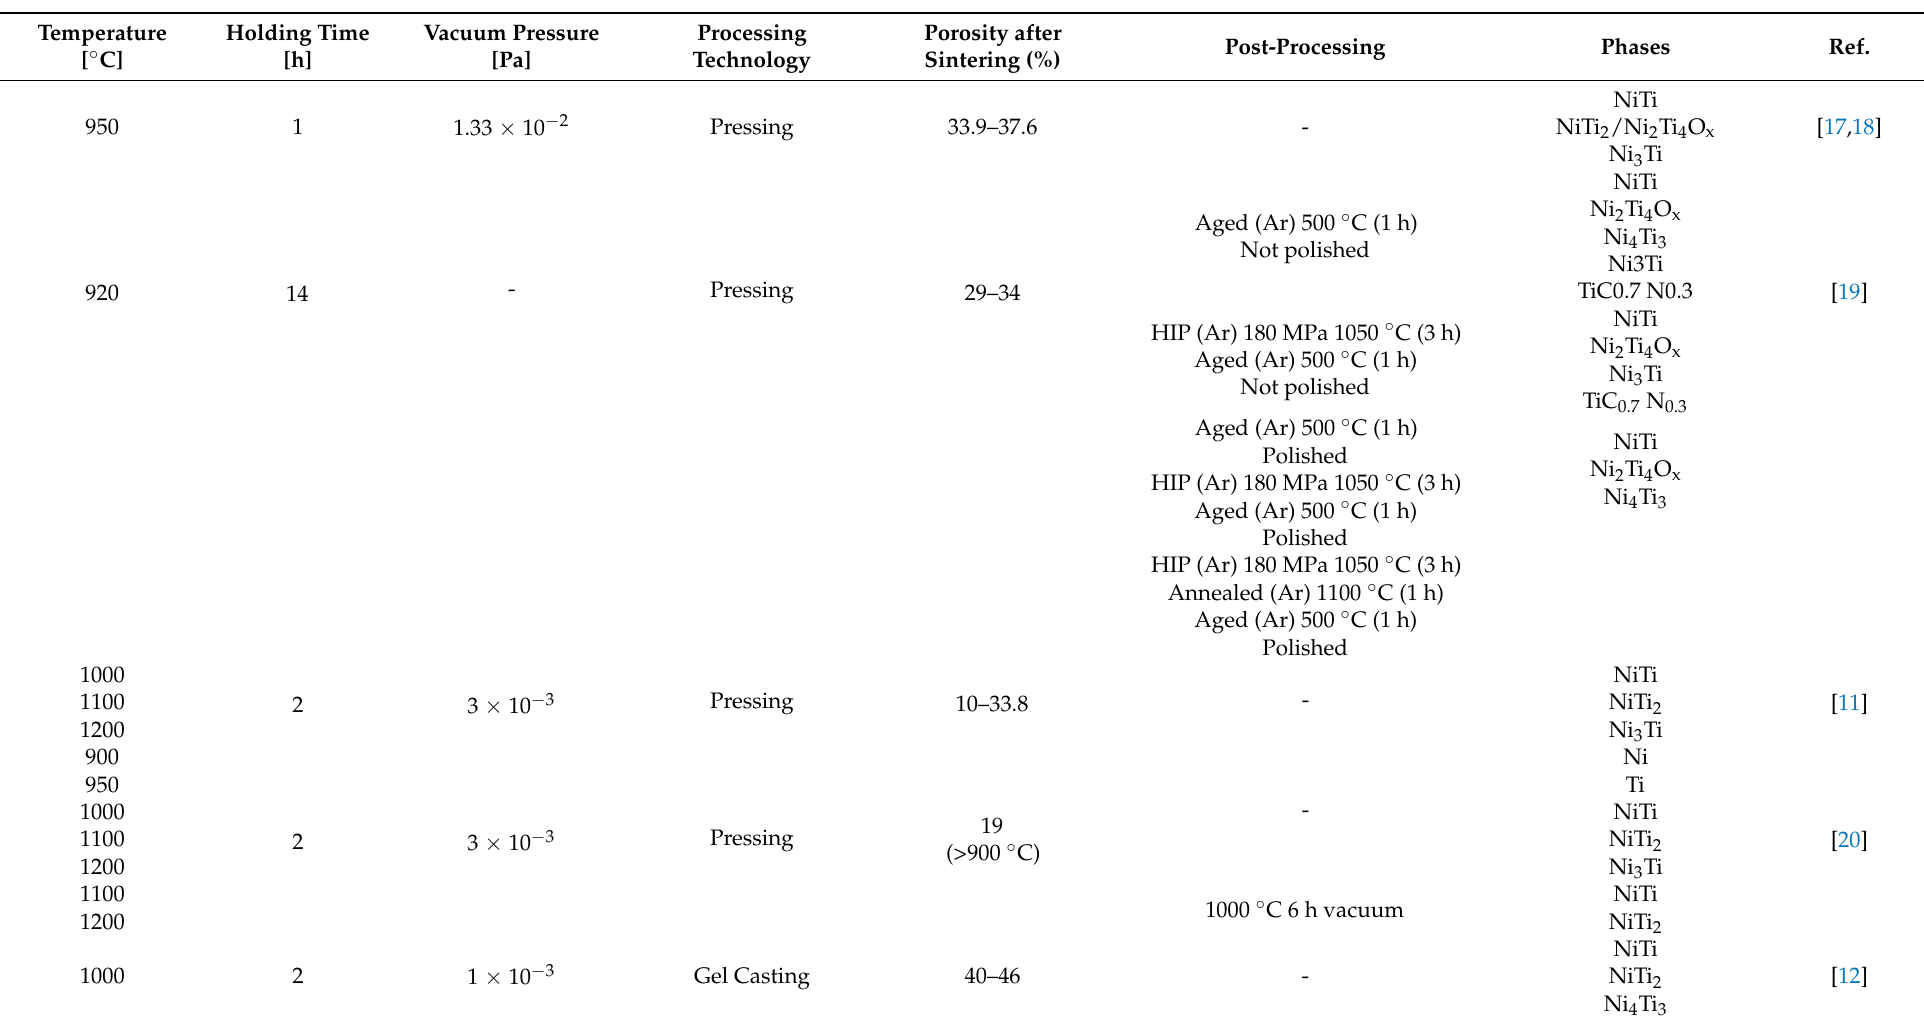
Table 1. Sintering and post-processing conditions of elemental Ni-TiH 2 powder and final